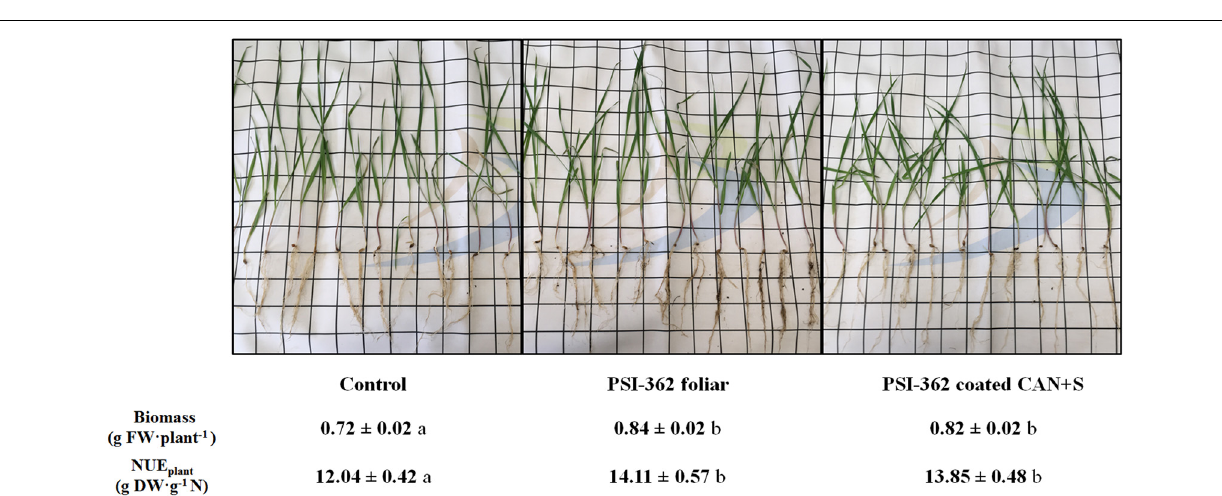
and 22.71% ( p = 0.050) compared to the untreated